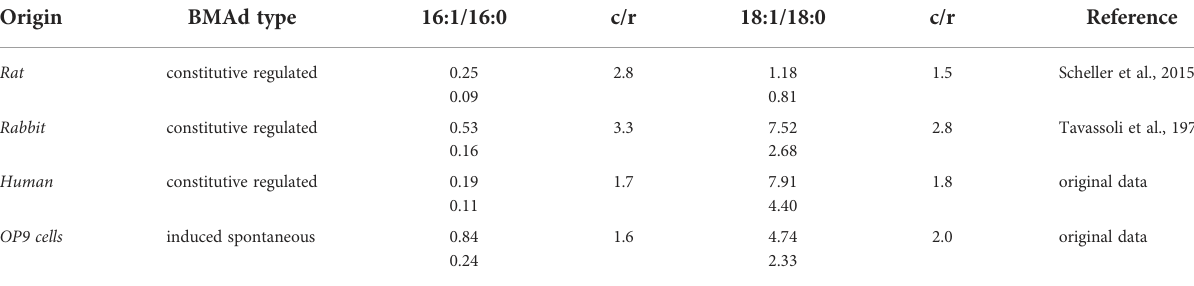
TABLE 1 Fatty acid unsaturation ratios in rat, rabbit, human, and OP9 cells from red and yellow BMAds.